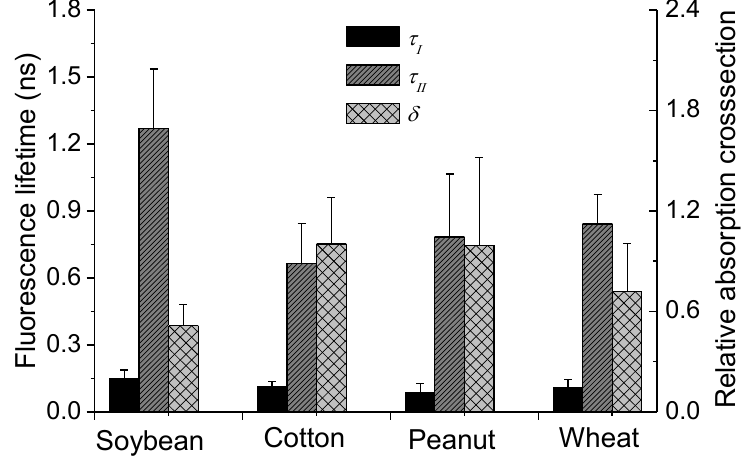
Figure 8. The fluorescence lifetimes of PSI and PSII (τ I and τ II ), the relative absorption cross section of PSI and PSII (δ), and the standard deviations by inverting the FluorMODleaf model for four crops’